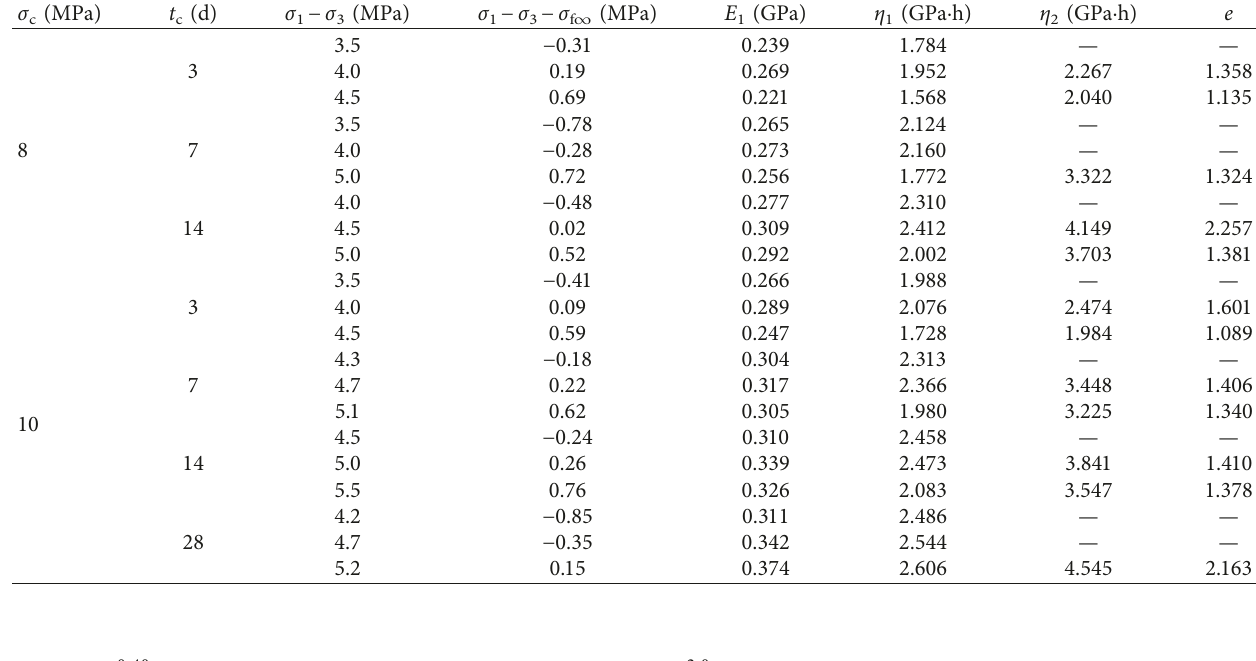
Table 7: The improved creep model